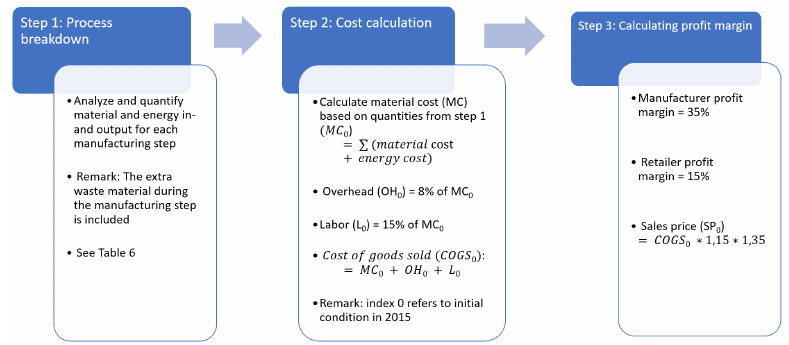
Figure 5. Overview of the used methodology including learning